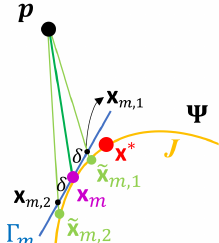
Figure 6. A schematic diagram of the m -th iteration of the FS algorithm, where p , Ψ , J , and x ∗ are defined the same as in Figure 5, x m is the point at m -th iteration, Γ m is the tangent plane of Ψ at x m